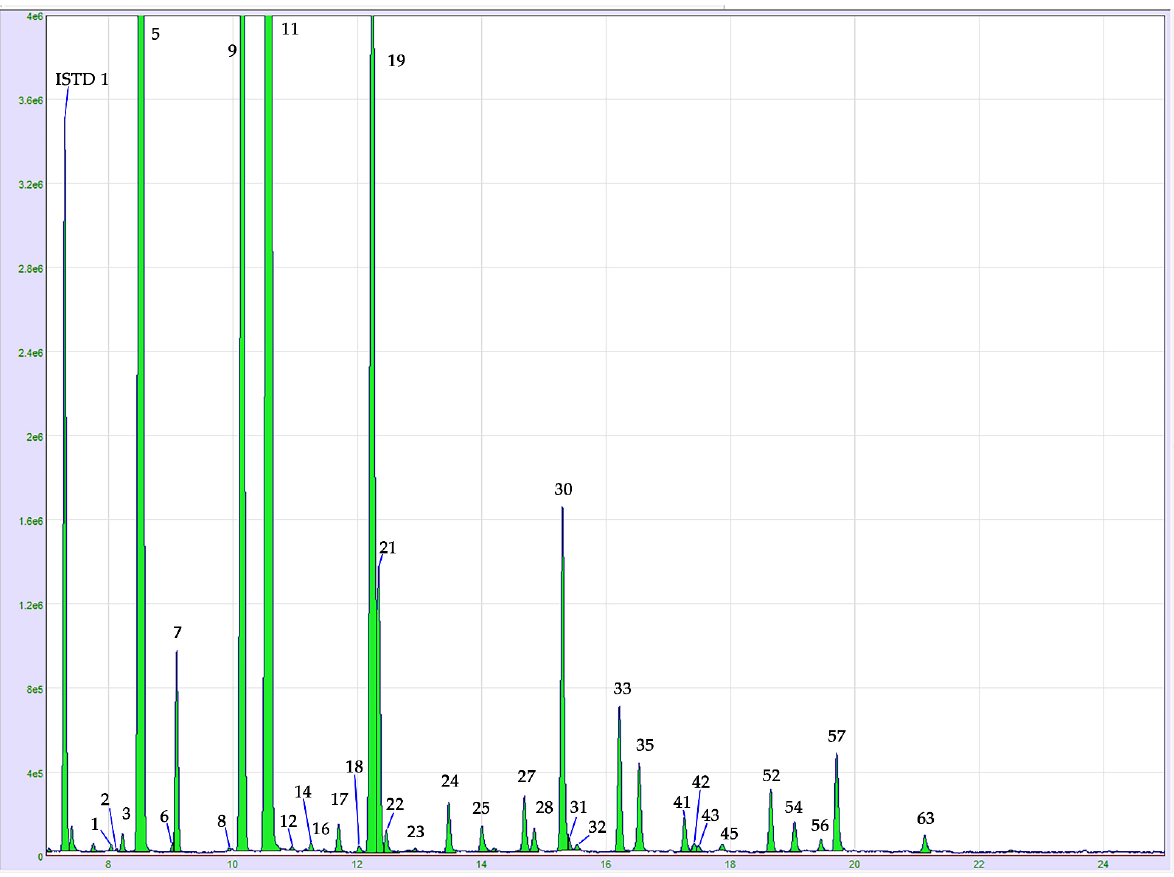
Figure 2. GC-MS chromatogram expansion of the monoterpene region in fresh hemp inflorescences, cv. Kompolti. For peak assignment, see the compounds listed in Table 1. Abbreviation: ISTD 1: nonane internal